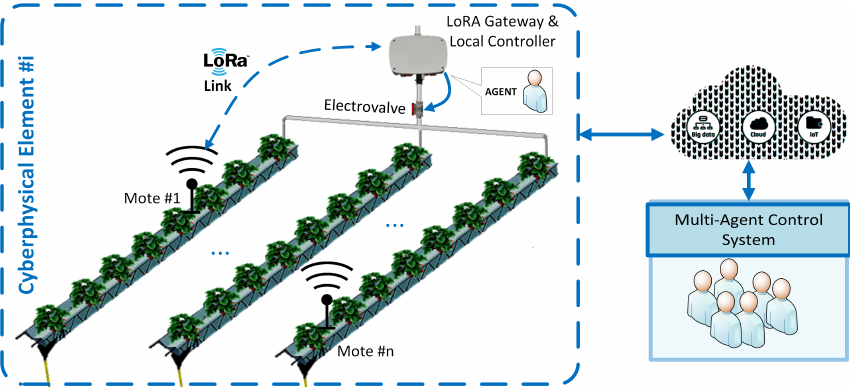
Figure 1. Schematic diagram of the cyberphysical fertigation element